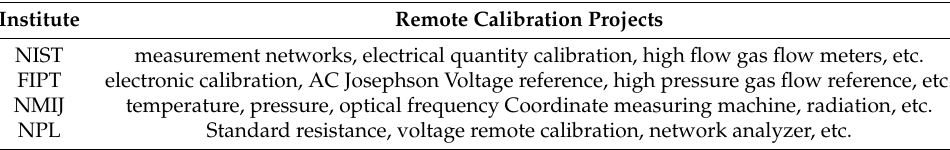
Table 1. International existing remote calibration